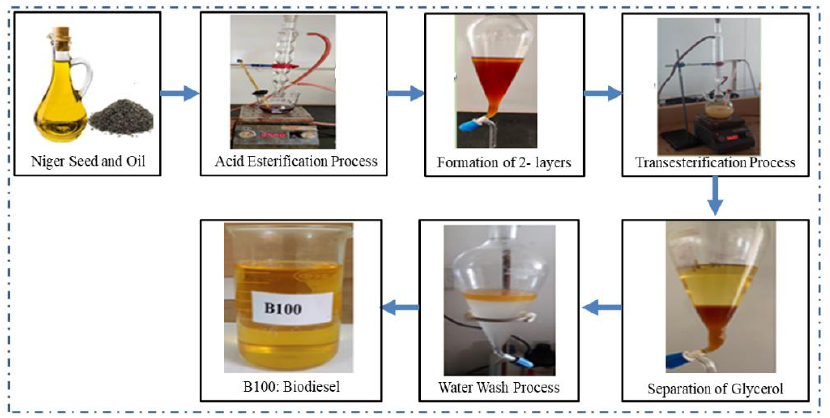
Figure 1. Framework for biodiesel conversion from niger seed oil.